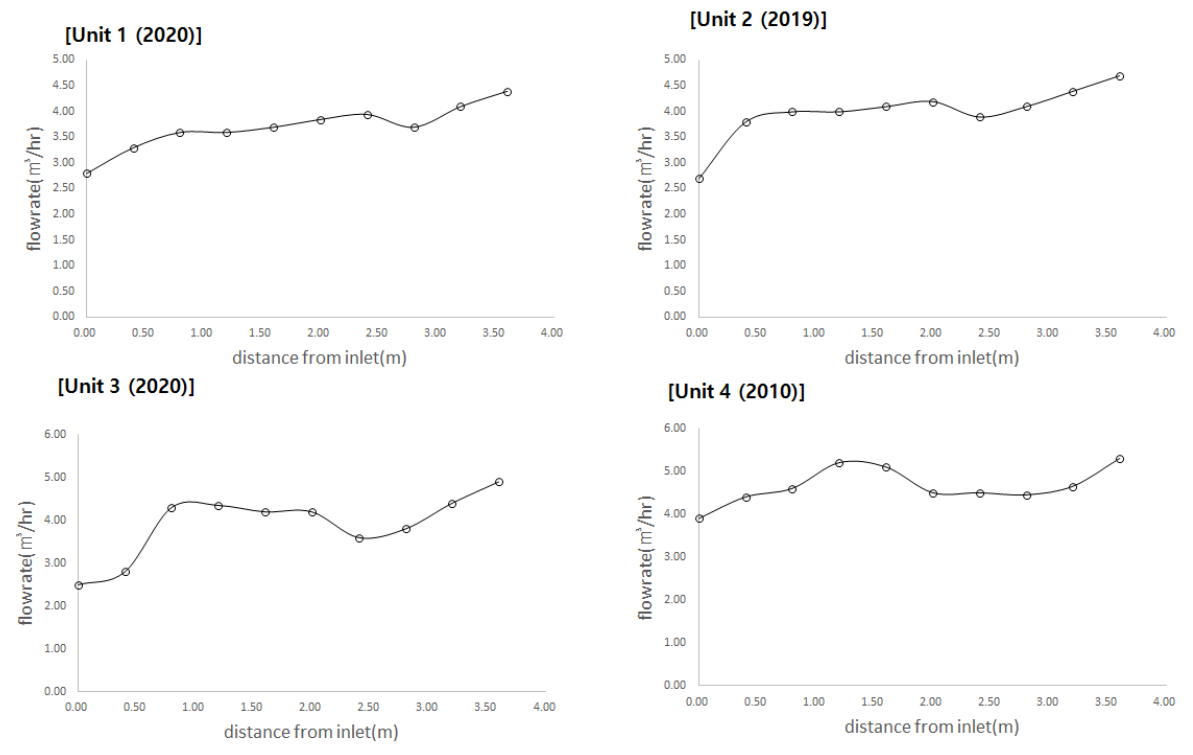
Figure 5. Flow distribution measurement results.